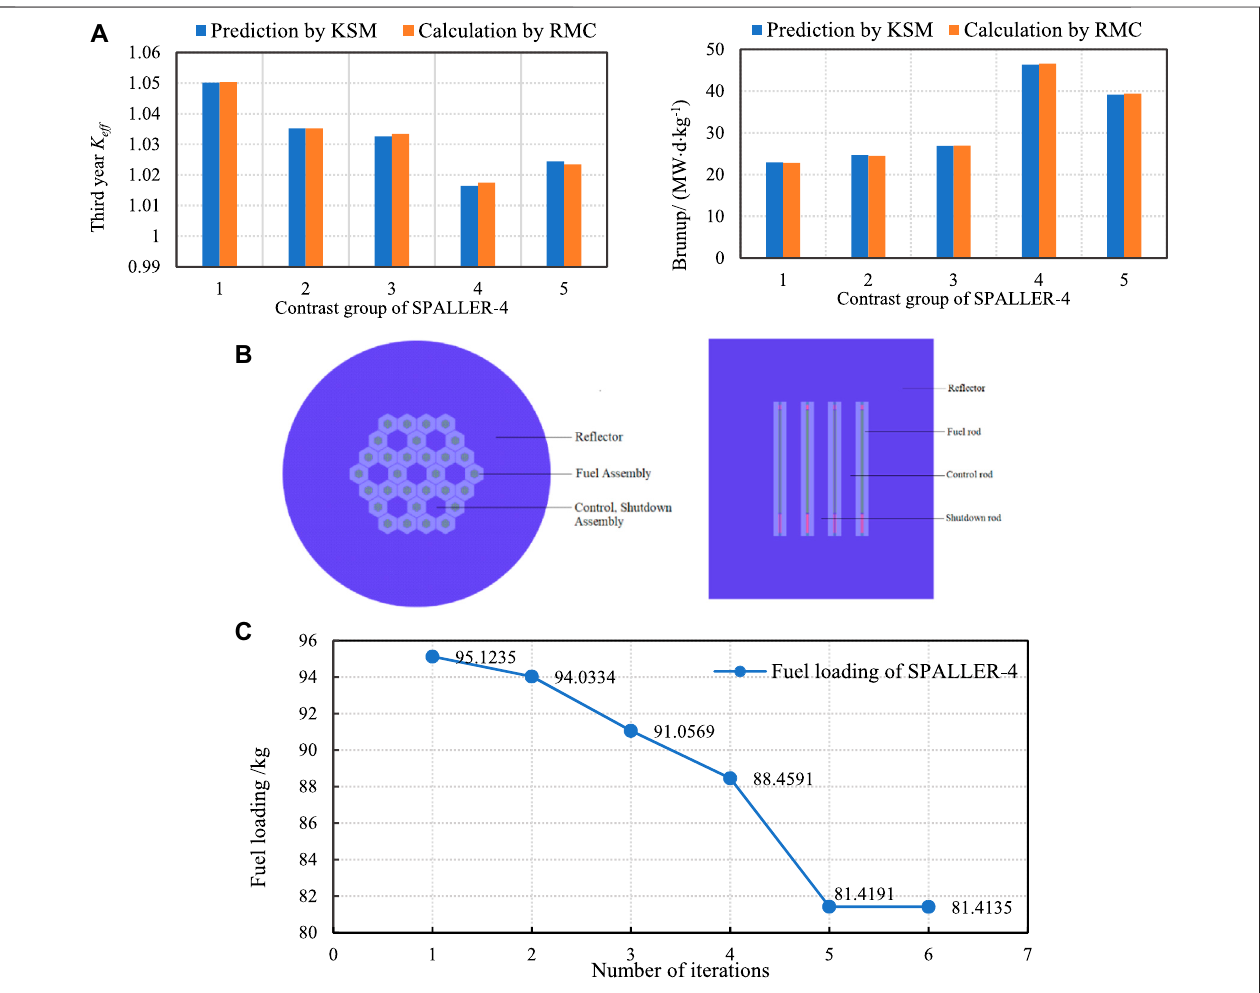
FIGURE4| Optimizationveri fi cationresultsofSPALLER-4. (A) Comparisonof K eff and burnupobtainedbasedonKSMandRMC, (B) Corestructure ofSPALLER- 4 to be optimized, (C) Iterative graph of fuel loading optimization for SPALLER-4.